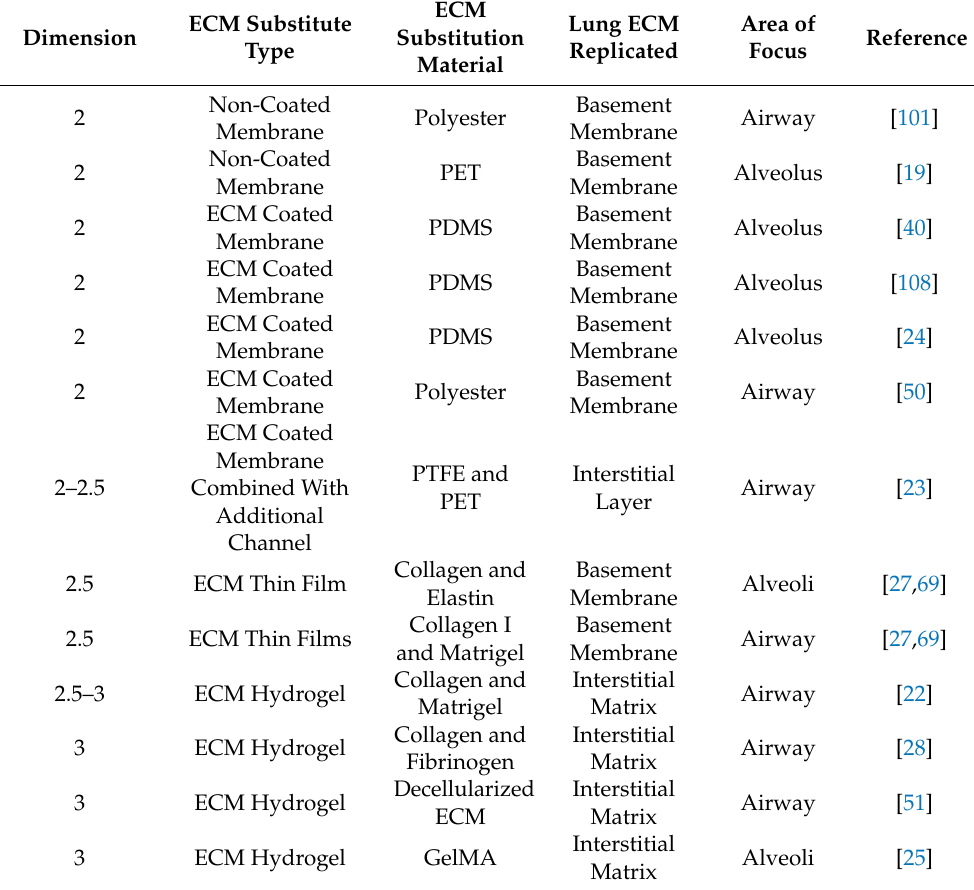
Table 2. ECM Dimensionality and Composition of Current Lung-On-A-Chip Devices. ECM Lung ECM Area of ECM Substitute Substitution Dimension Replicated Type Material